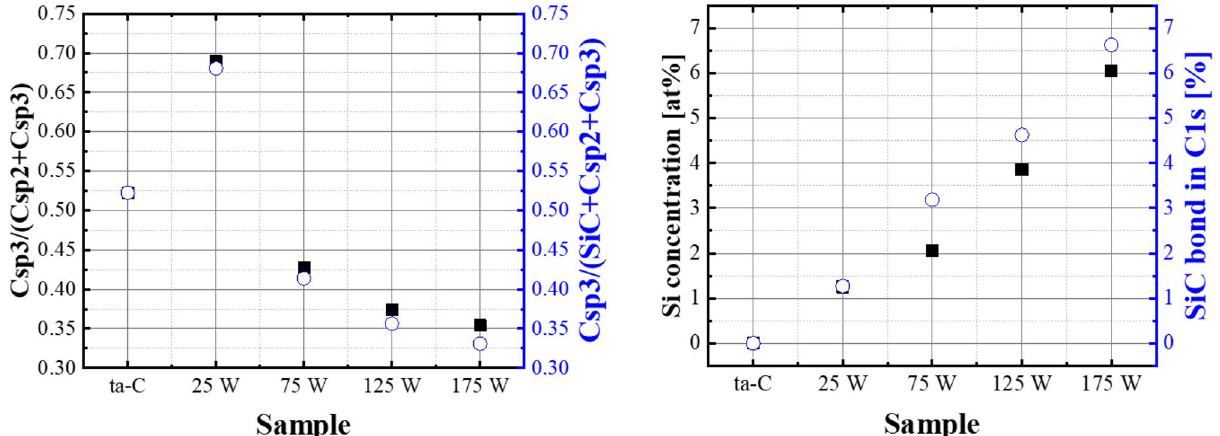
Figure 3. Behavior of C(sp 3 )/C(sp 2 ) ratio and Si atomic percent and SiC bond percent of tetrahedral amorphous carbon (ta-C) and Si/SiC/ta-C composite (Si–ta-C) coatings as a function of unbalanced magnetron (UBM) sputtering power from the X-ray photoelectron spectroscopy (XPS) C 1 s spectra.